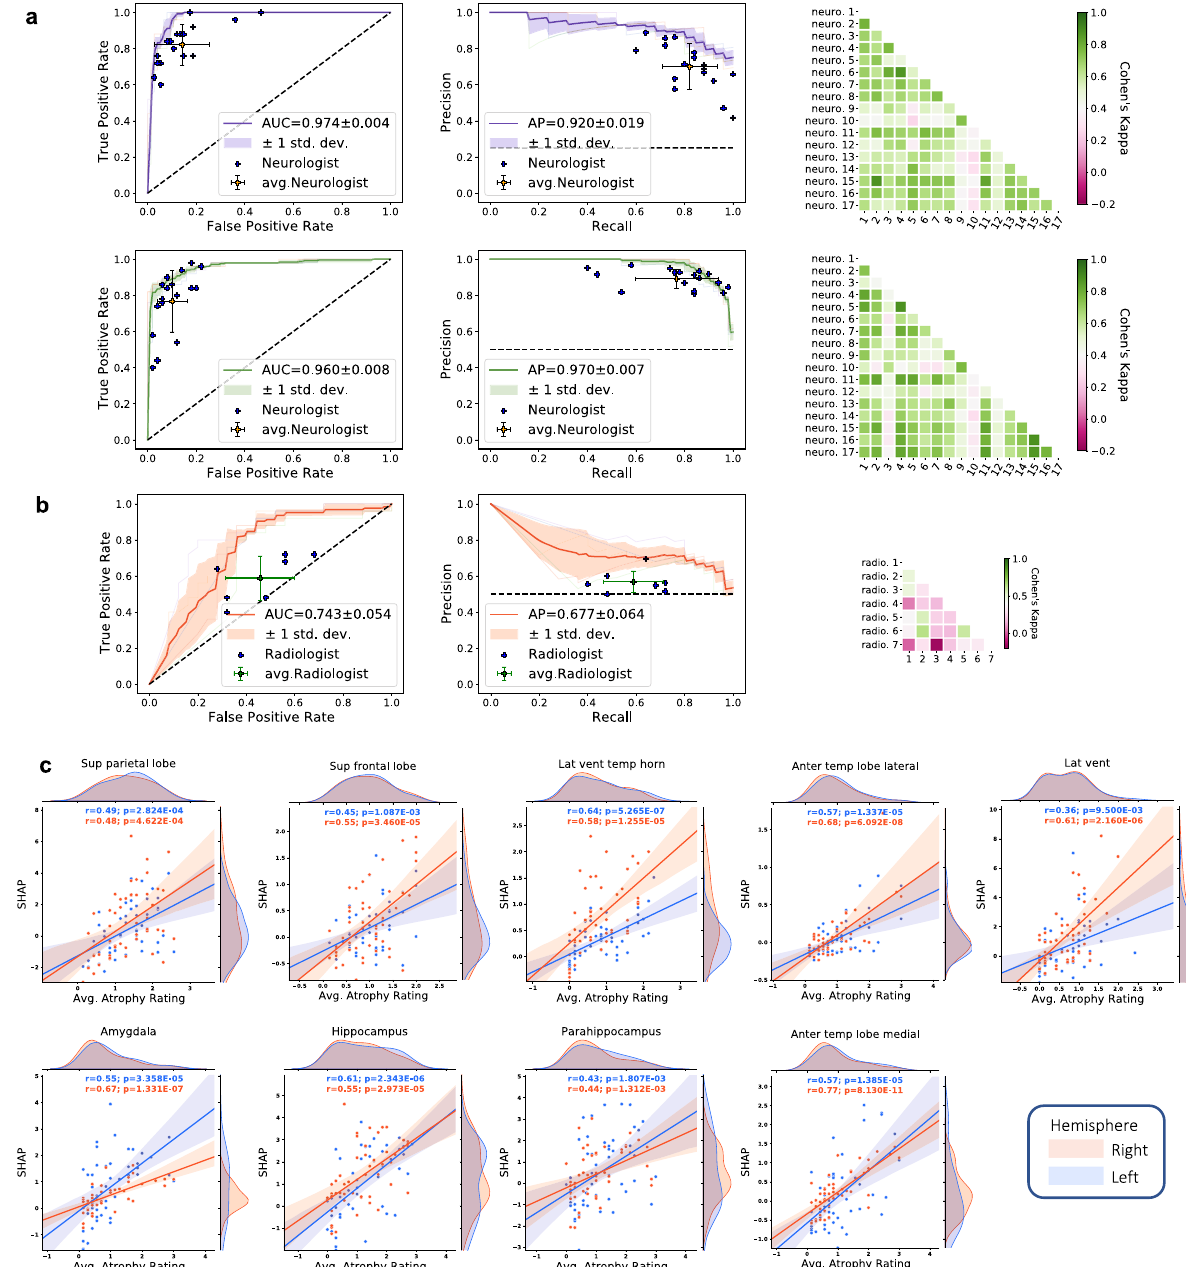
Fig. 6 Expert-level validation. a For the COG NC task (Row 1), the diagnostic accuracy of board-certi fi ed neurologists ( n = 17) is compared to the performance of our deep learning model using a random subset of cases from the NACC dataset ( n = 100). Metrics from individual clinicians are plotted in relation to the ROC and PR curves from the trained model. Individual clinician performance is indicated by the blue plus symbol and averaged clinician performance along with error bars is indicated by the green plus symbol on both the ROC and PR curves. The mean ROC/PR curve and the standard deviation are shown as the bold line and shaded region, respectively. A heatmap of pairwise Cohen ’ s kappa statistic is also displayed to demonstrate inter- rater agreement across the clinician cohort. For the COG DE task (Row 2), ROC, PR, and interrater agreement graphics are illustrated with comparison to board-certi fi ed neurologists in identical fashion. For these tasks, all neurologists were granted access to multimodal patient data, including MRIs, demographics, medical history, functional assessments, and neuropsychological testing. The same data was used as input to train the deep learning model. b For validation of our ADD task, a random subset ( n = 50) of cases with dementia from the NACC cohort was provided to the team of neuroradiologists ( n = 7), who classi fi ed AD versus those with dementia due to other etiologies (nADD). As above, the diagnostic accuracy of the physician cohort is compared to model performance using ROC and PR curves. Graphical conventions for visualizing model and clinician performance are as described above in a and, once more, pairwise Cohen ’ s kappa values are shown to demonstrate inter-rater agreement. c SHAP values from the second convolutional layer averaged from selected brain regions are shown plotted against atrophy scores assigned by neuroradiologists. Orange and blue points (and along with regression lines and 95% con fi dence intervals) represent left and right hemispheres, respectively. Spearman correlation coef fi cients and corresponding two-tailed p values are also shown and demonstrate a statistically signi fi cant proportionality between SHAP scores, and the severity of regional atrophy assigned by clinicians. Source data are provided as a Source Data fi